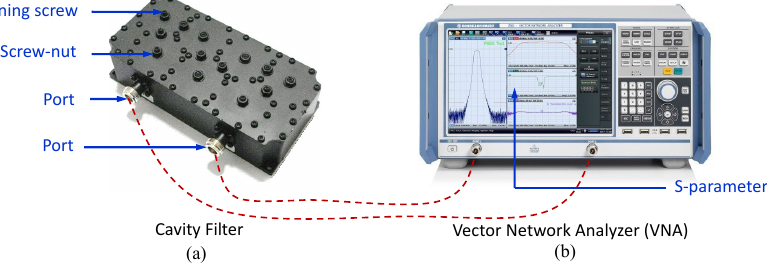
Figure 1. The overview of cavity filter tuning task: ( a ) A cavity filter with screws and screw-nuts to be tuned. ( b ) An R&S ZND Vector Network Analyzer (VNA) displays the S–parameter curves. Red dashed splines indicate cables for connecting the cavity filter device under test and the